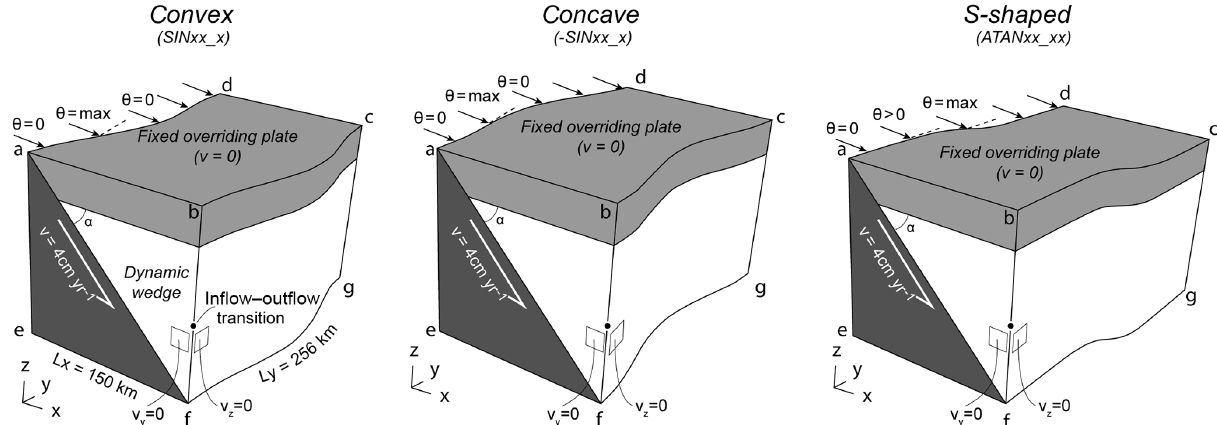
Figure 2. Setting of the computed models with the kinematic boundary condition. Initial thermal state is computed following the half-space cooling model following the formulation of Turcotte and Schubert (2014) with a 25Myr old oceanic lithosphere for the downgoing slab and a 5Myr old lithosphere for the upper plate. The physical dimensions are identical for each model and are specified on the convex setting. The number of elements is 65 × 85 × 65 in the x , y and z direction, respectively, leading to a physical resolution of 2.3 × 3 × 2.30km for each model.